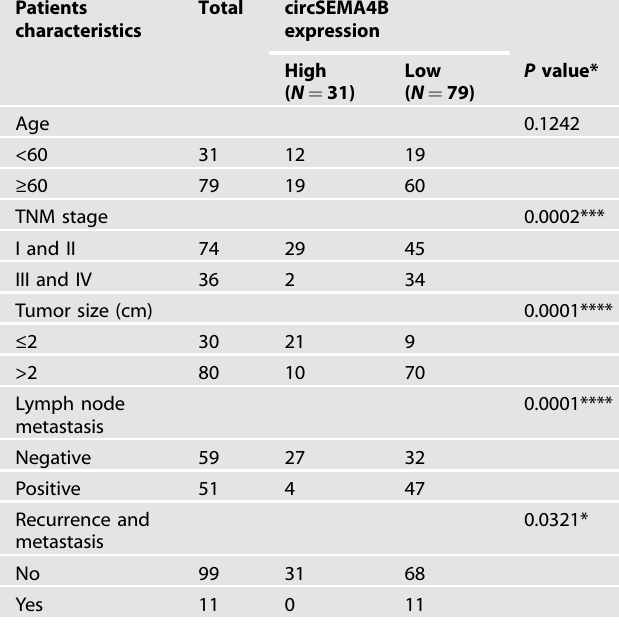
Table 1. The relationship between the expression of circSEMA4B and various clinicopathological